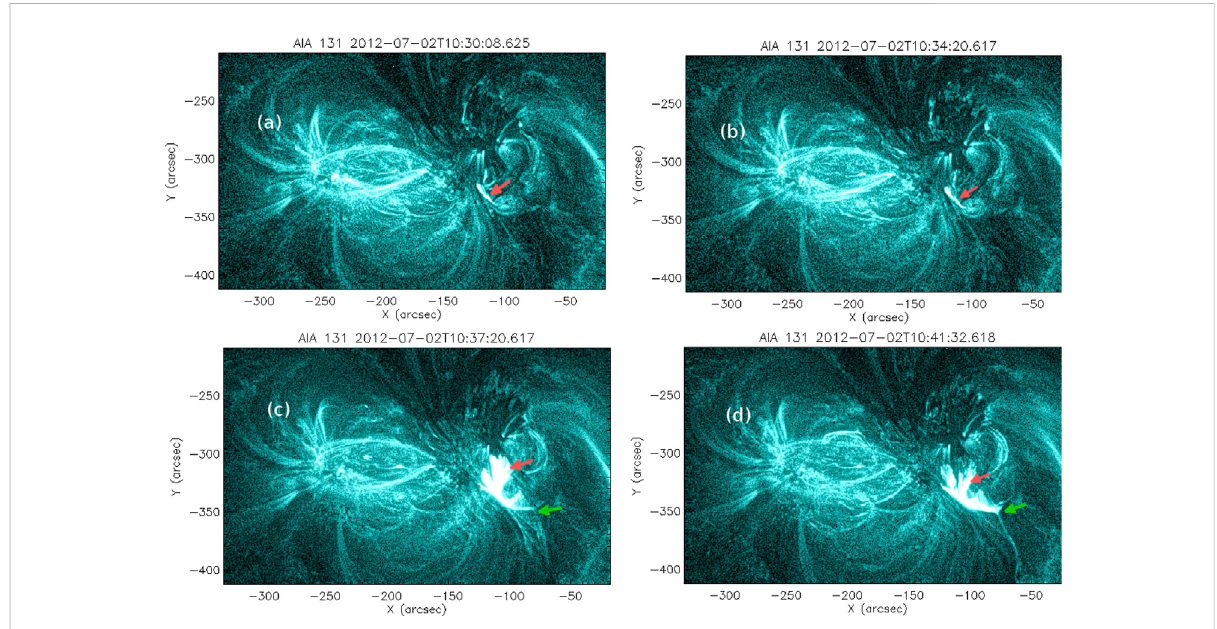
FIGURE 1 The appearance of the brightenings and its subsequent bifurcations in 131 Å are marked by red arrows in panels (A – D) . Also notable is the faint southward spray of plasma [marked by green arrow in panels (C,D) ].